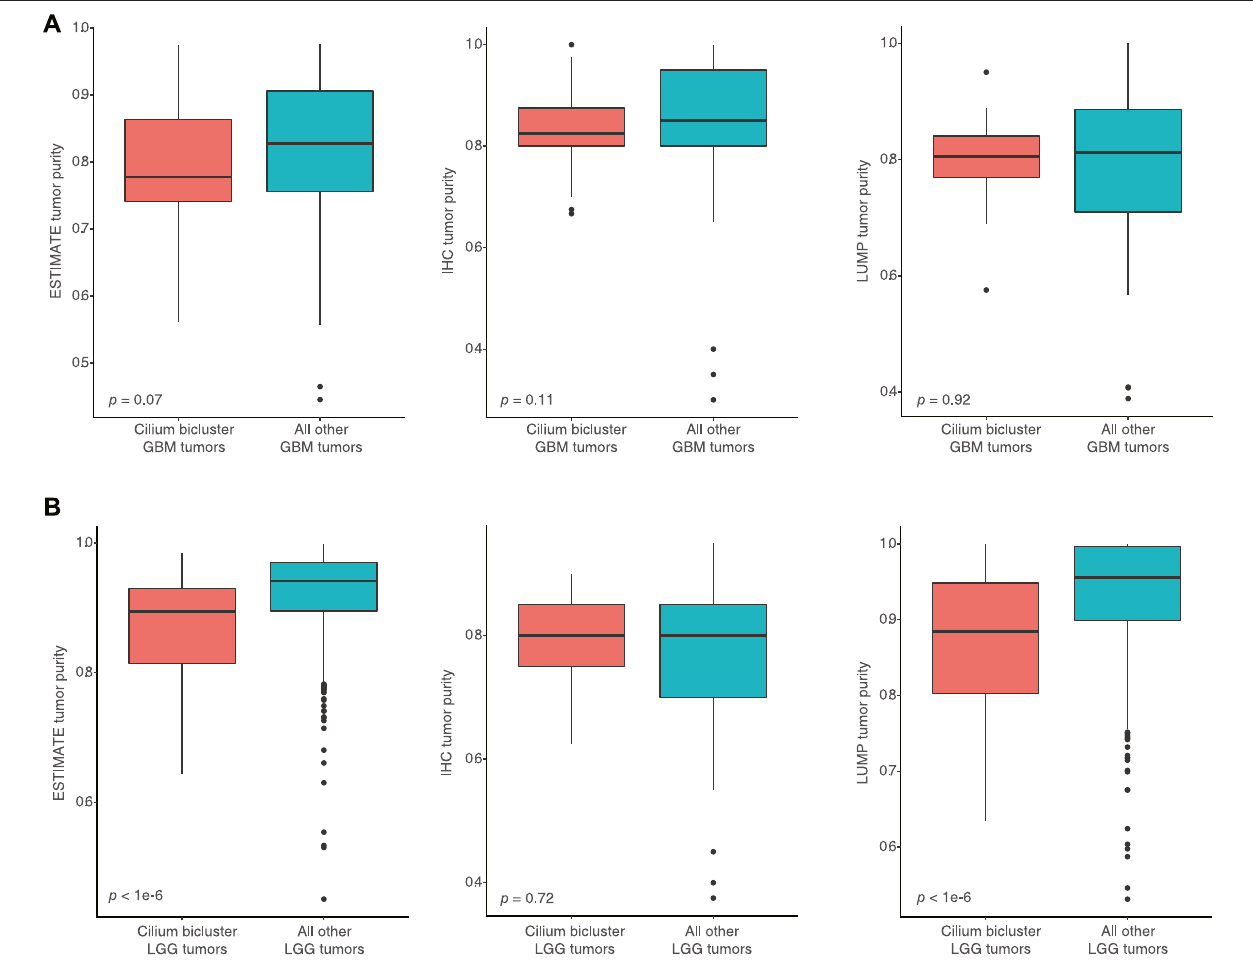
FIGURE6|(A) Nosigni fi cantdifferencesincomputationalandIHC-basedpurityassessmentsforGBMsampleswithvs.withoutcilium-associatedexpression. (B) Signi fi cantdifference incomputationalpurityestimates byESTIMATE and LUMPforLGG tumorsinthe cilium bicluster compared toother LGG tumors, contrasting with no signi fi cance difference in their IHC-based purity